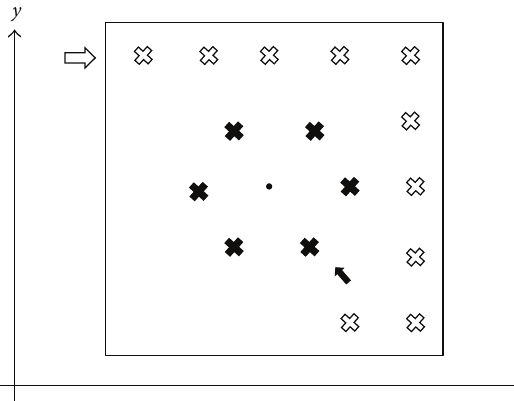
Figure 9: Visual tags of the straight and circular path of the Har- monic Walk . The straight path (white crosses) follows the interface perimeter and displays an 11-unit musical sequence, while the cir- cular path (black crosses), centered with respect to the application’s surface, displays the six harmonic space chords distribution. The 𝑥 - axis corresponds to the interface width; the 𝑦 -axis is the interface